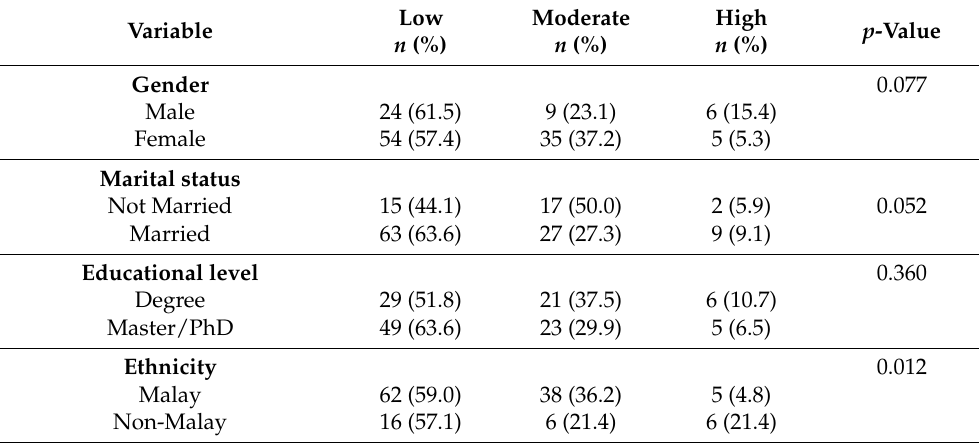
Table 5. Association between Marital Status, Educational Level, Ethnicity, Gender and Intention to